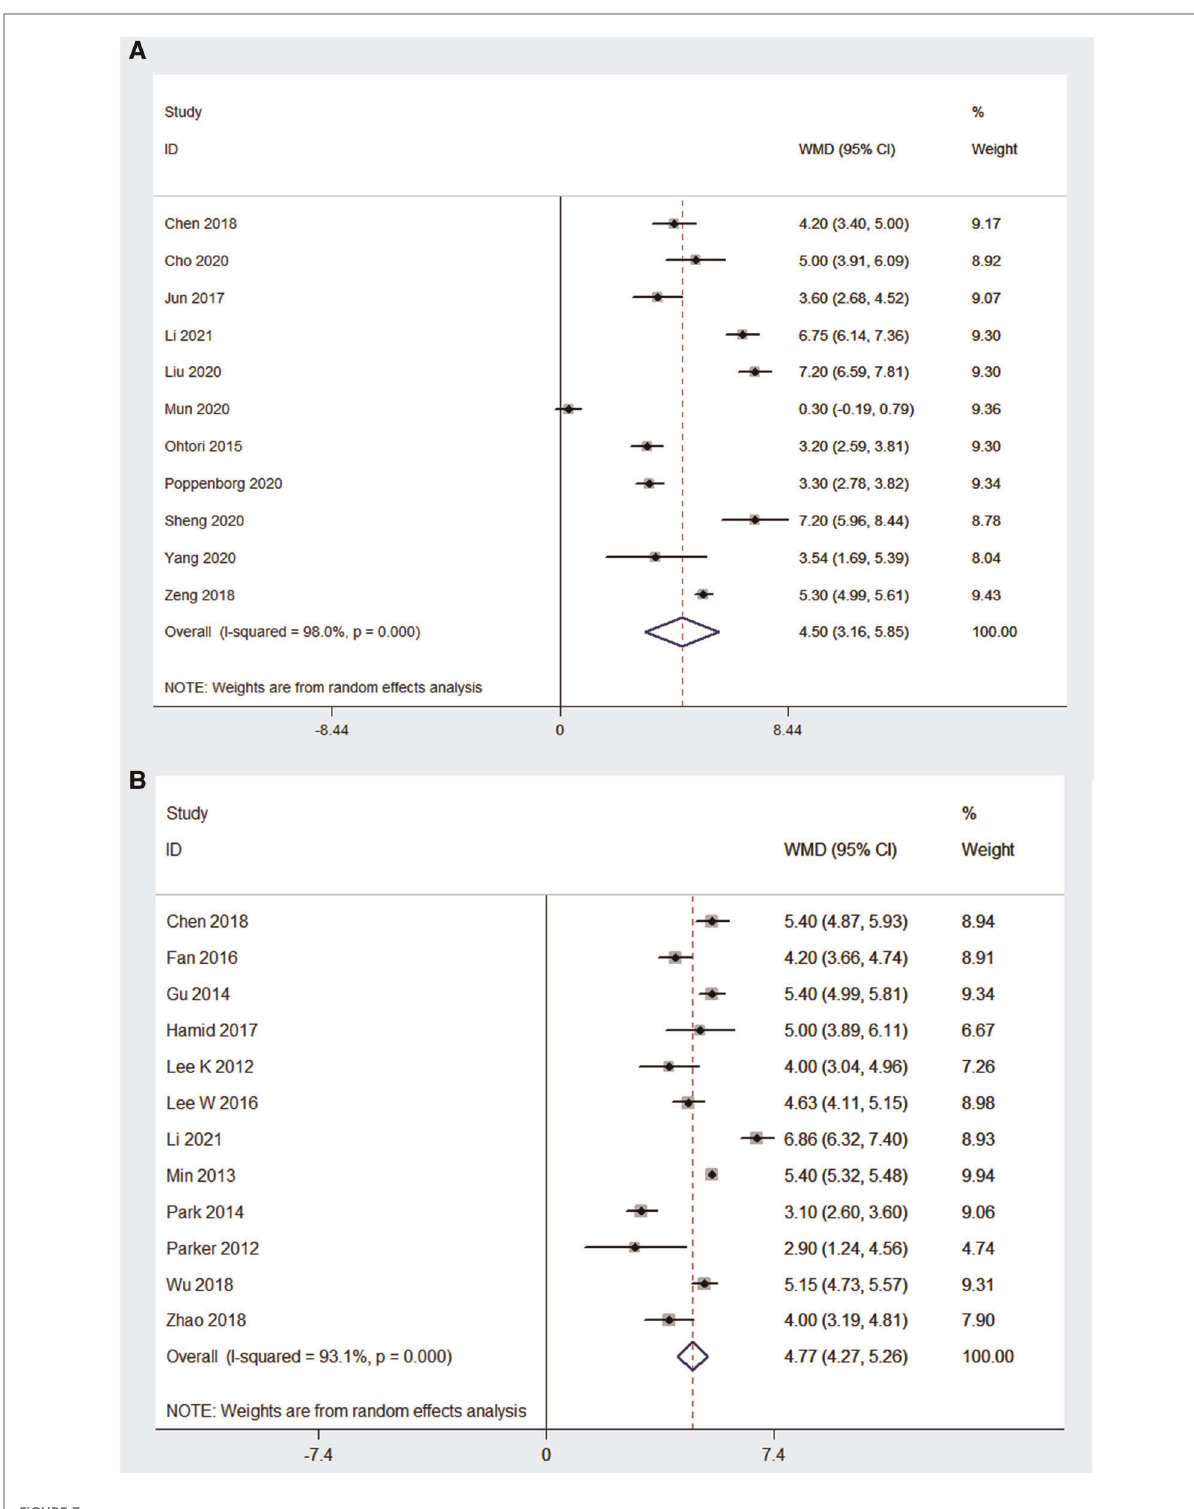
FIGURE 7 Forest plot and pooled estimates of visual analog scale. Outcomes assessed are ( A ) OLIF group; ( B ) MI-TLIF